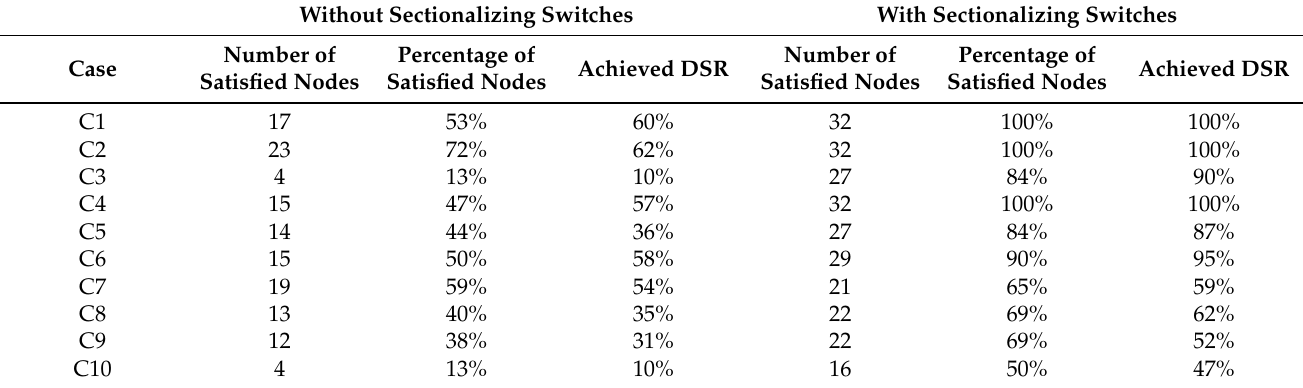
Table 2. Results of the tested instances on the virtual